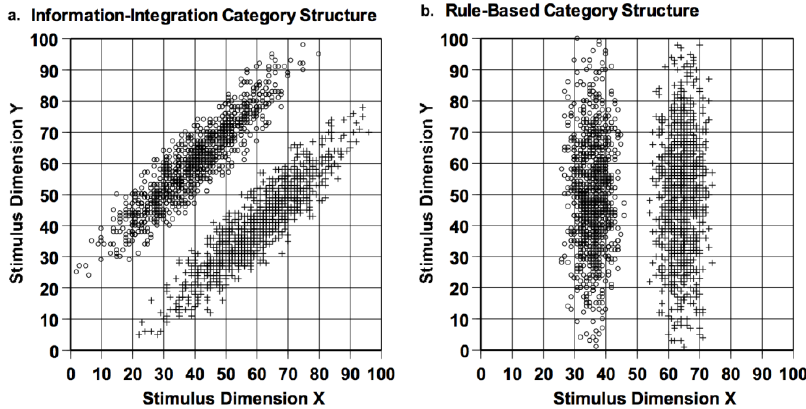
Figure 12. (a) An information-integration category structure, depicted within an abstract 100 × 100 stimulus space. The open-circle and plus-sign symbols, respectively, indicate Category A and Category B stimuli; and (b) a rule-based category structure, depicted in the same